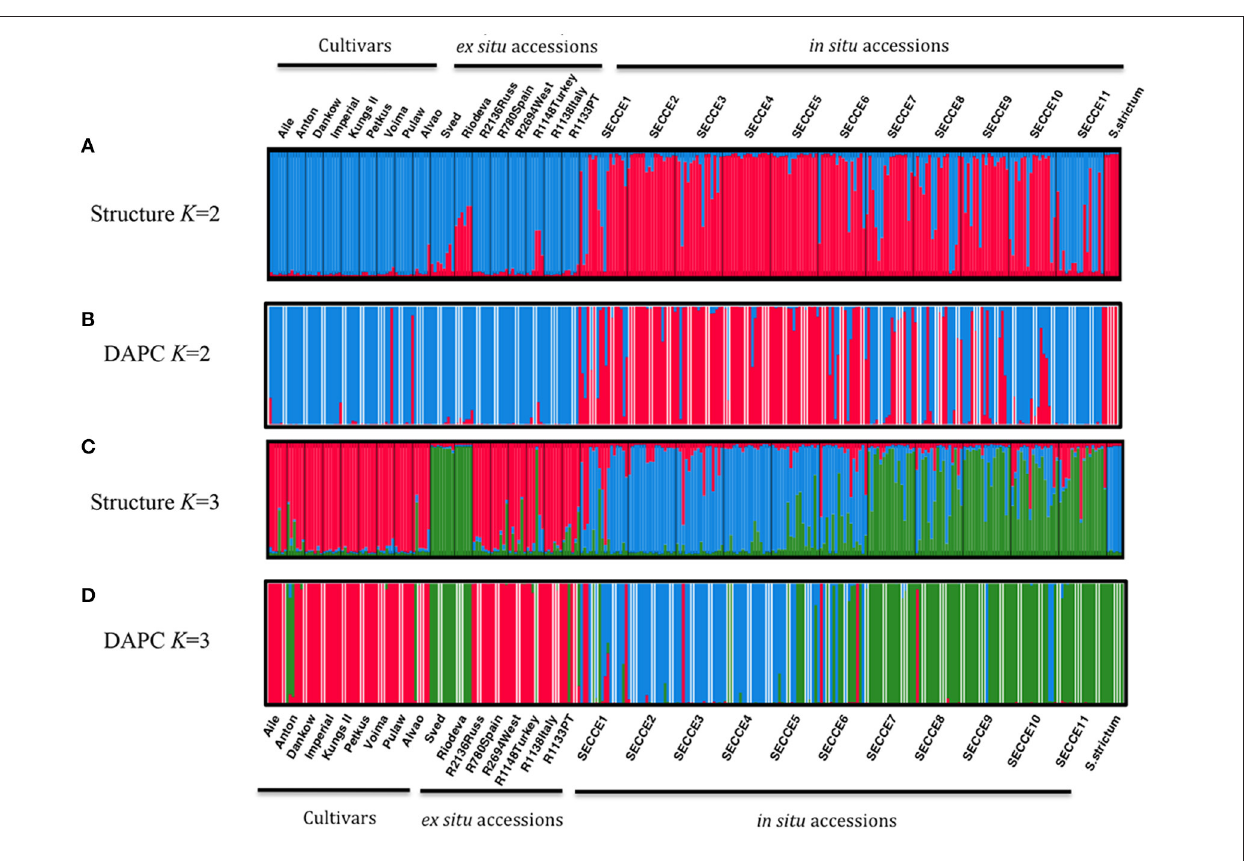
FIGURE 4 | Clustering based on SSR data using STRUCTURE ( K = 2, A; K = 3, C) and DAPC ( K = 2, B; K = 3, D) analysis. Each rye accession is organized following the grouping as cultivars, ex situ and in situ accessions. The length of each section is proportional to the estimated ancestry value of the individual